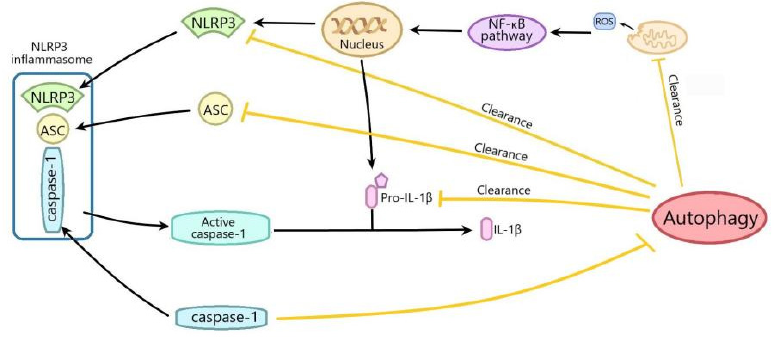
Figure 4. The mechanisms of the interplay between autophagy and NLRP3 inflammasome.